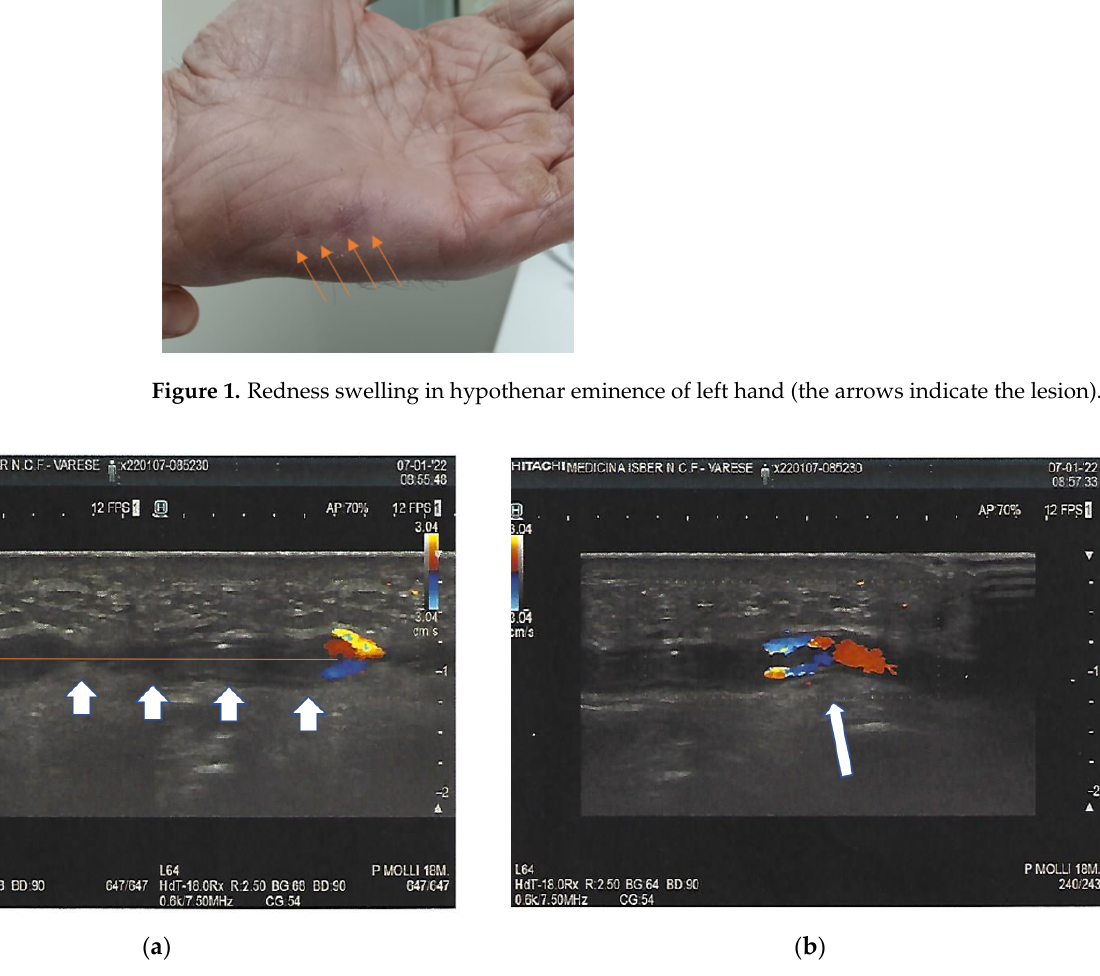
Figure 2. Subocclusive arterial thrombosis of the arcuate branch of the ulnar artery. The arrows indicate the thrombosis in all its length ( a ); Doppler image shows how the blood flow spreads by crossing the intraluminal thrombus (arrow) ( b ).